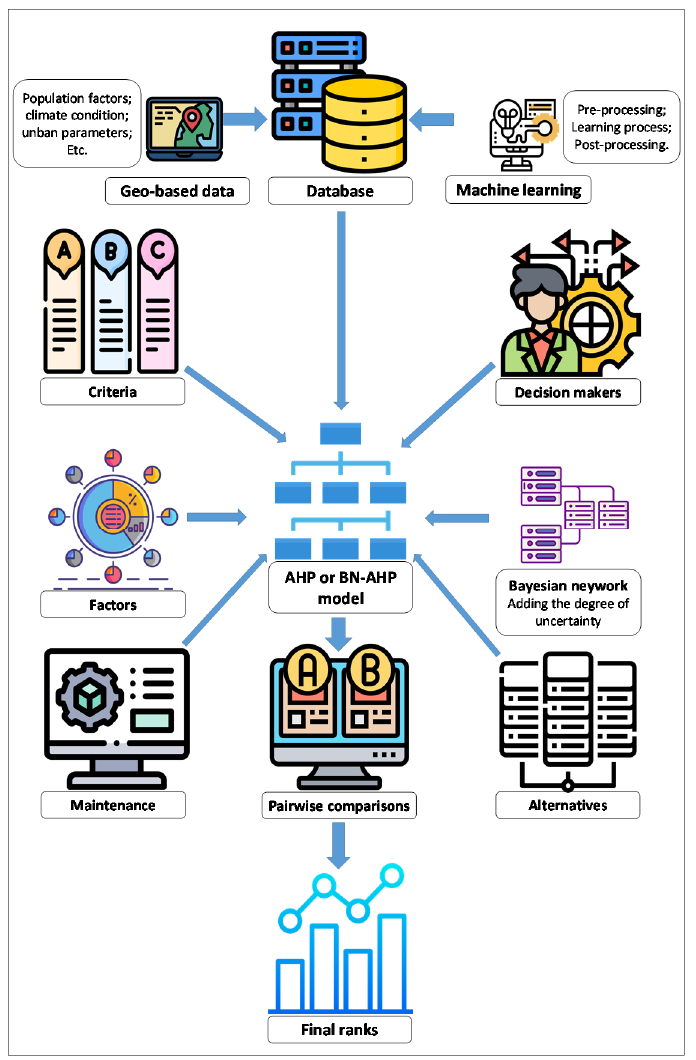
Figure 1. The analysis flowchart of Geo-AHP and BN-Geo-AHP by using machine